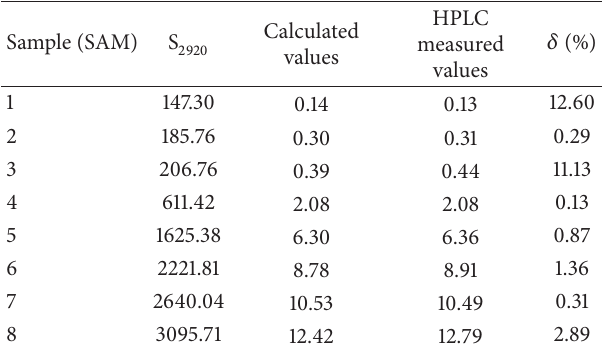
Table 1: The calculated and measured results of 8 samples with the relative